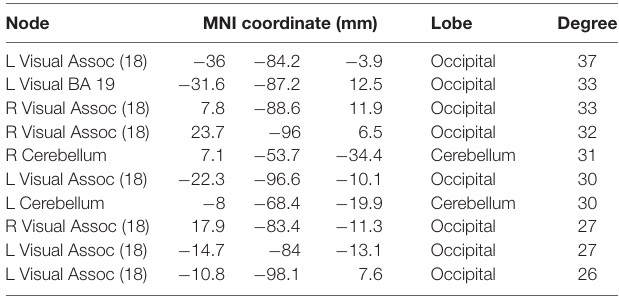
TABLE 2 | Ten nodes with the most connections selected by the prediction model. Node MNI coordinate (mm)